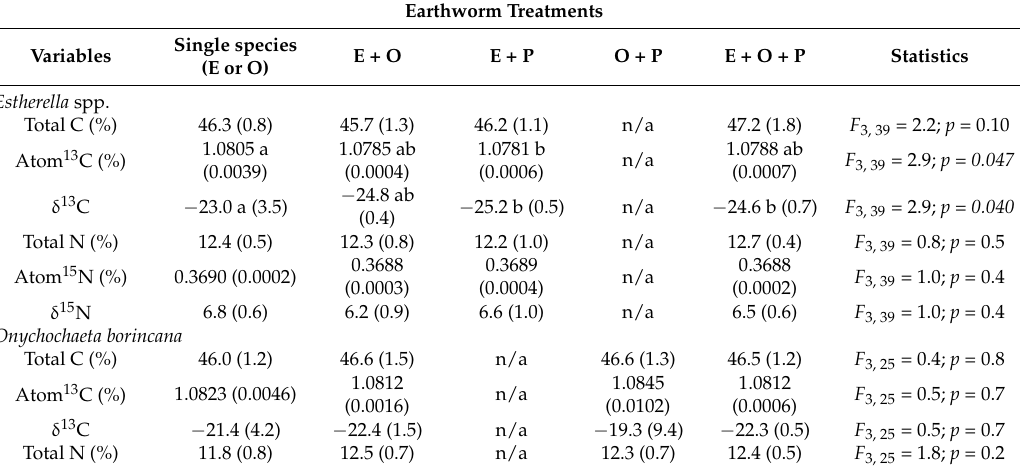
Table 3. Earthworm tissue total carbon (C) and nitrogen (N) percentages (%), atom percentages of 13 C and 15 N (%), and delta 13 C ( δ 13 C; ‰) and delta 15 N ( δ 15 N; ‰) in native earthworms Estherella spp. (E) and Onychochaeta borincana (O) at each earthworm mesocosm from different earthworm treatments at the end of the 22-day experiment with Puerto Rican